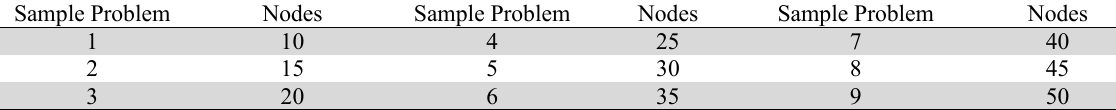
Size of sample issues designed in larger sizes Sample Problem Nodes Sample Problem Nodes Sample Problem Nodes